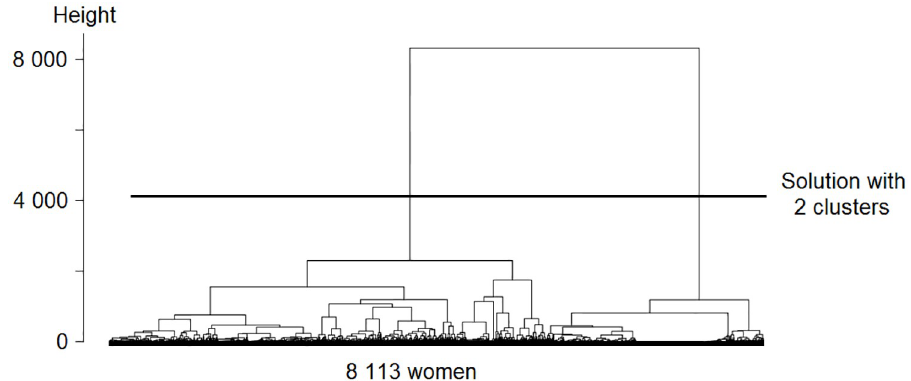
Fig 3. Dendrogram for the clusters among women. The model fit is 0.79 Point Biserial Correlation, 0.61 Average Silhouette Width, 16 932 Calinski-Harabasz index using squared distances, 0.91 Hubert’s Somers’ D, and 0.05 Hubert’s